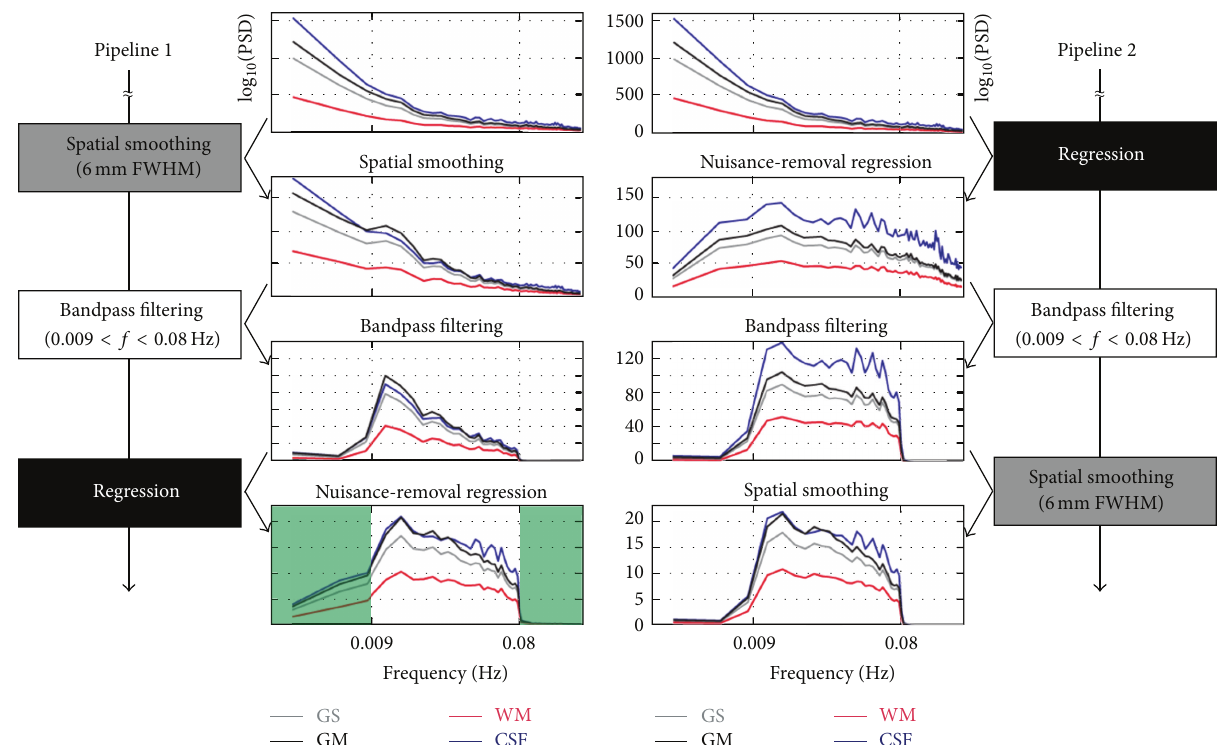
Figure 3: Group averaged power spectrum densities (PSD) of resting-state FMRI time series within brain tissues for each step in two different preprocessingorders.Theimproperprocessingorder(pipeline1)canreintroducenoisefrequencycomponents(signalsofnointerest)inlower frequency bands ( 𝑓 < 0.009 Hz, the green-tinted area) and higher frequency bands (see the text for more